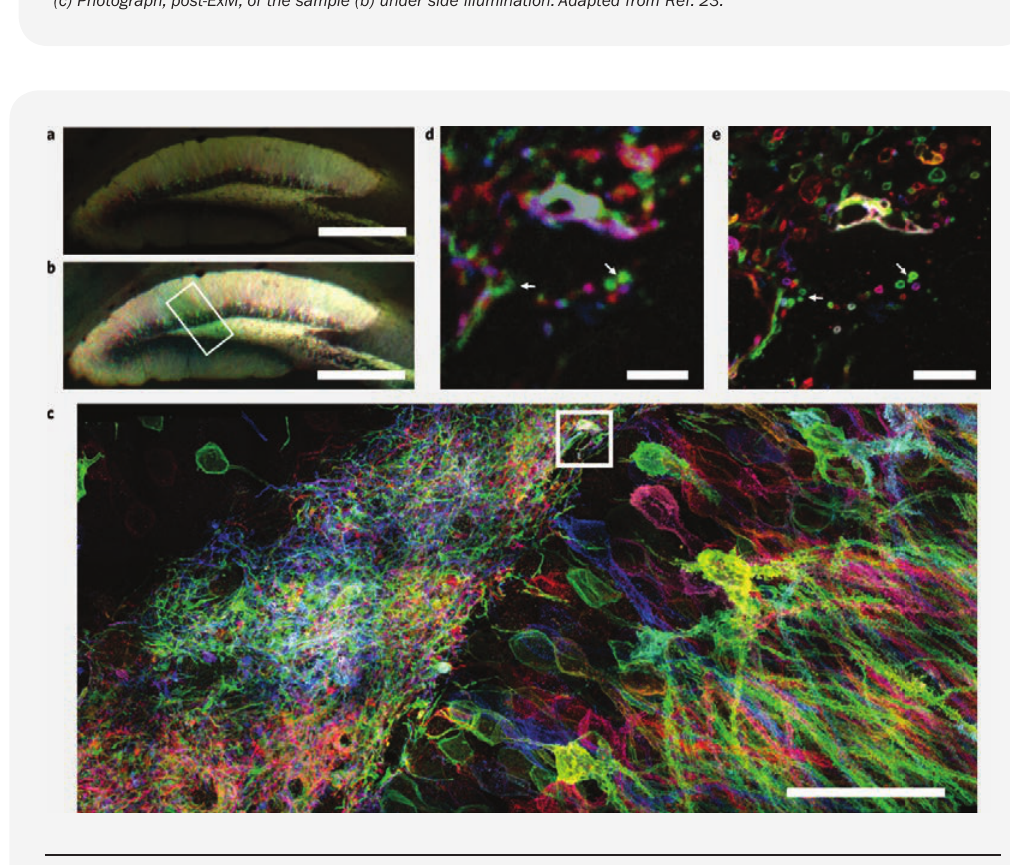
Figure 8. Expansion microscopy of Brainbow-labeled brain. (a) Low-magnifi cation widefi eld fl uorescence imaging showing im- munostained mouse hippocampus expressing virally delivered Brainbow3.0. (b) Post-expansion widefi eld image of the sample in a. (c) Maximum intensity projection of high-resolution confocal microscopy stack following expansion of membrane labeled Brain- bow3.0 neurons from the boxed region in b. (d) Pre-expansion confocal image showing one optical section of the boxed region in c. (e) Post-expansion image of d. Scale bars: (a) 500 μ m, (b) 500 μ m (in biological units), (c) 50 μ m (in biological units), (d) 5 μ m, (e) 5 μ m (in biological units). Adapted from Ref.